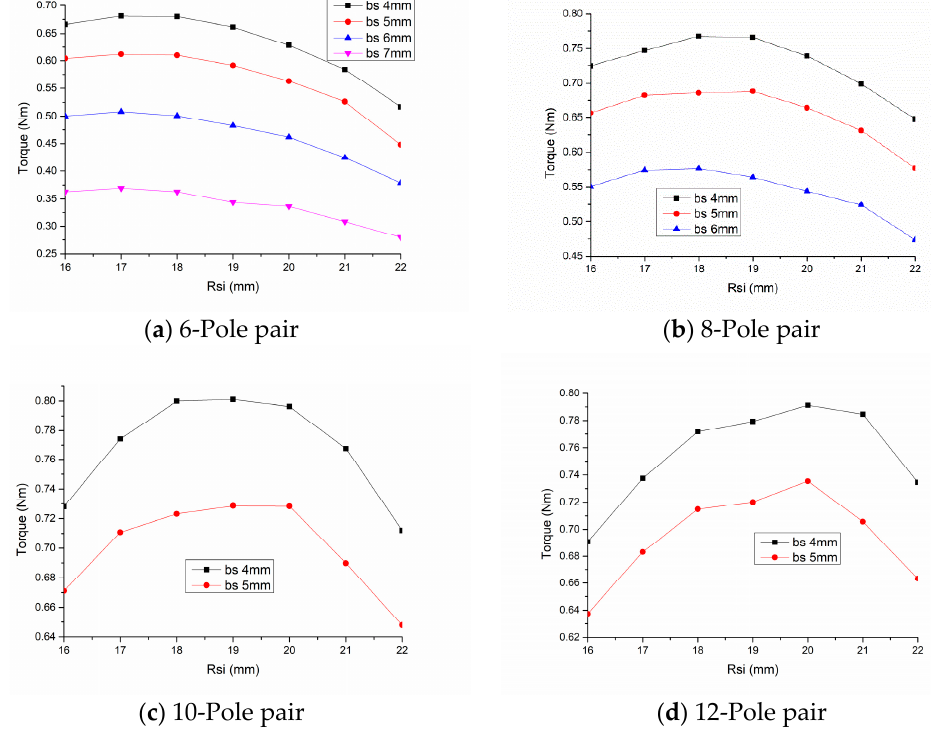
Figure 7. Torque of CPM with variation of the stator inner radius and stator wall thickness.